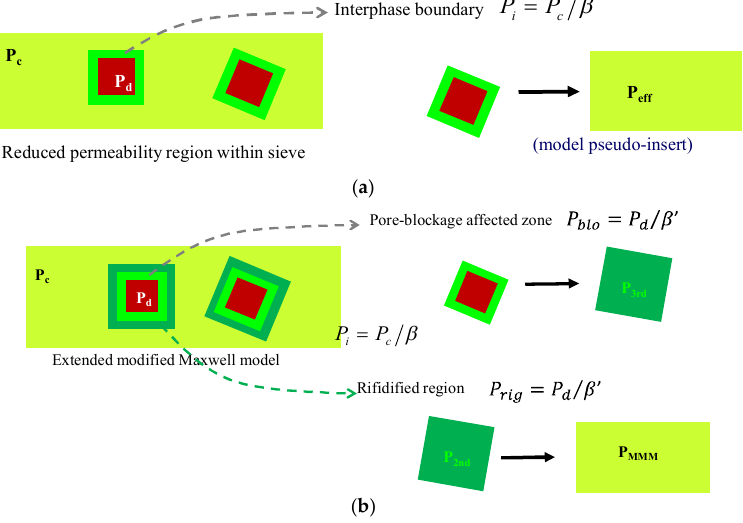
Figure 3. Schemes of the modified Maxwell model proposed by Moore et al. [26] ( a ) and the extended modified Maxwell model proposed by Li et al. [27] ( b ), both adapted for this work.